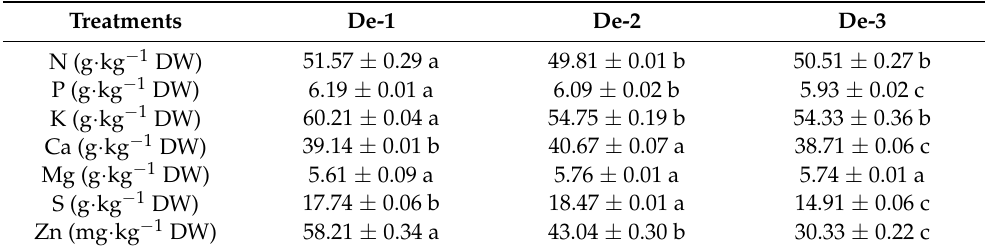
Table 2. The content of mineral elements of kale grown under different depths of nutrient solution.